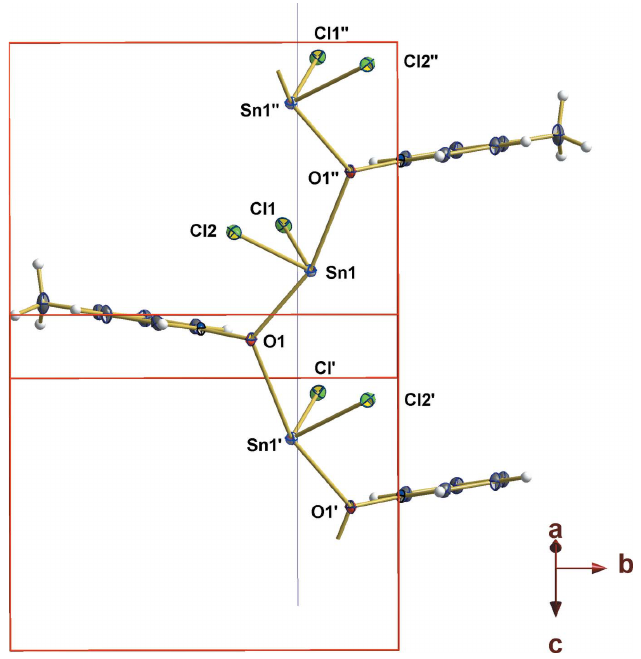
Figure 3 Ball-and-stick model of the one-dimensional coordination polymer of 1 viewed parallel to the glide plane (blue line); symmetry codes used to generate equivalent atoms: ( 0 ) x , 3